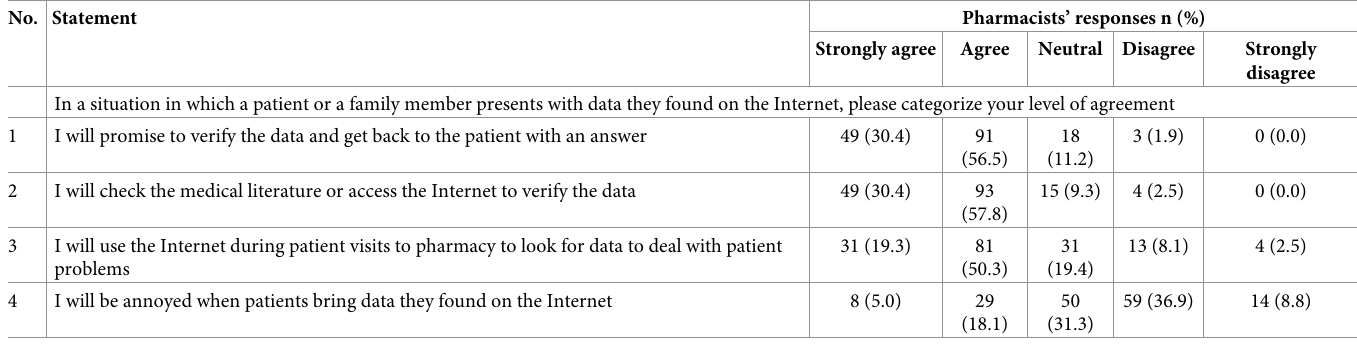
Table 3. Pharmacists expected behavior to patients’ inquiries about Internet-based medication information. No.